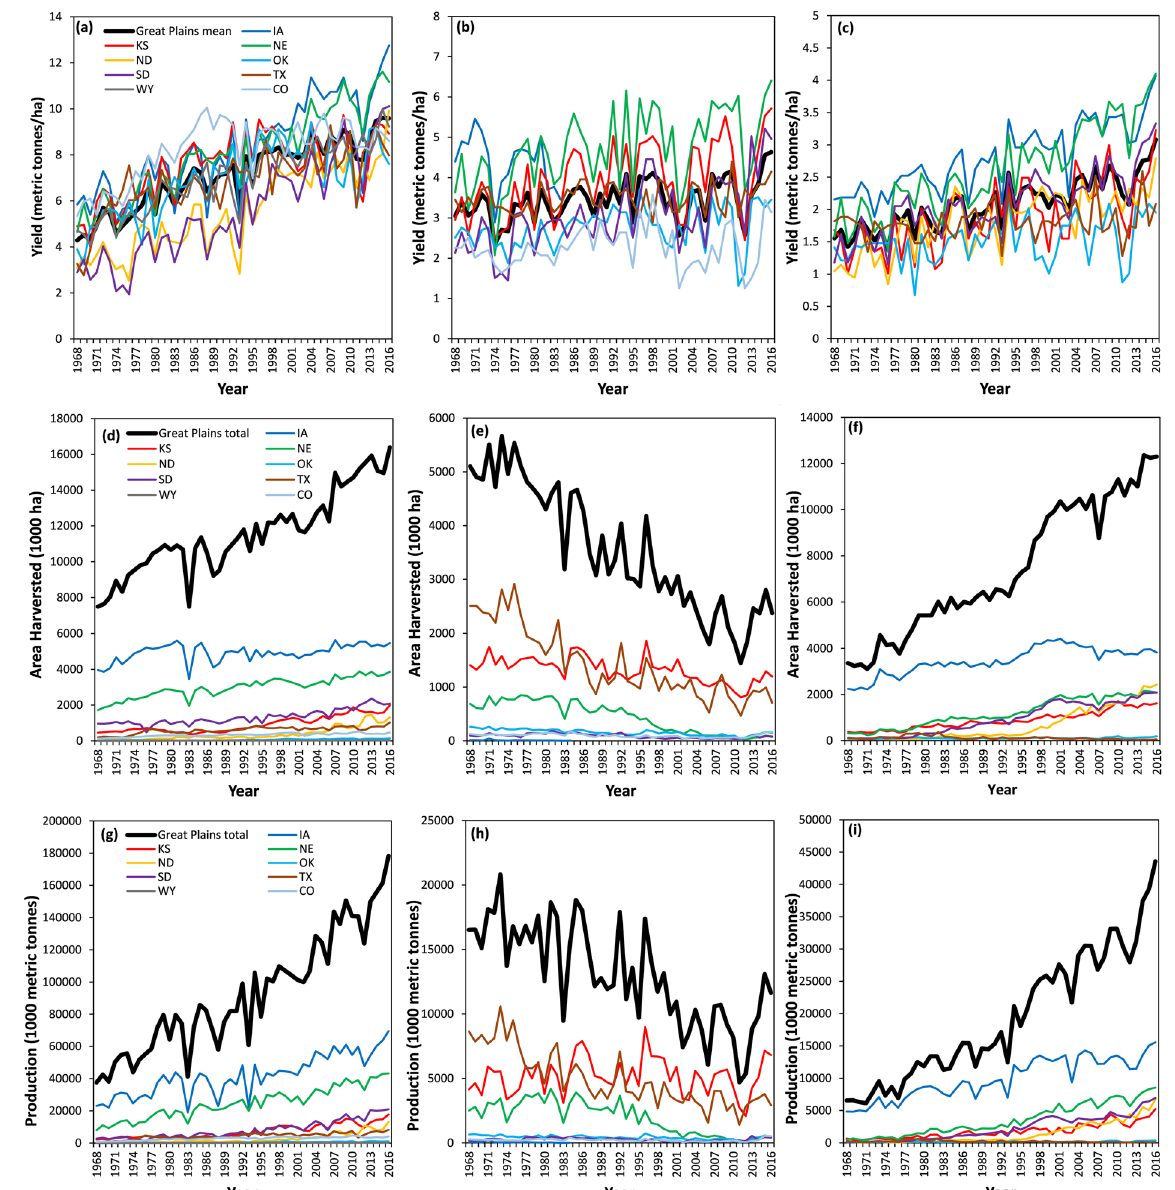
Figure 1. State-specific trends in ( a ) Maize yield ( b ) Sorghum yield ( c ) Soybean yield ( d ) Maize harvested area ( e ) Sorghum harvested area ( f ) Soybean harvested area ( g ) Maize production ( h ) Sorghum production ( i ) Soybean production for the period 1968–2016. The thick black line in each chart depicts regional statistics across all the